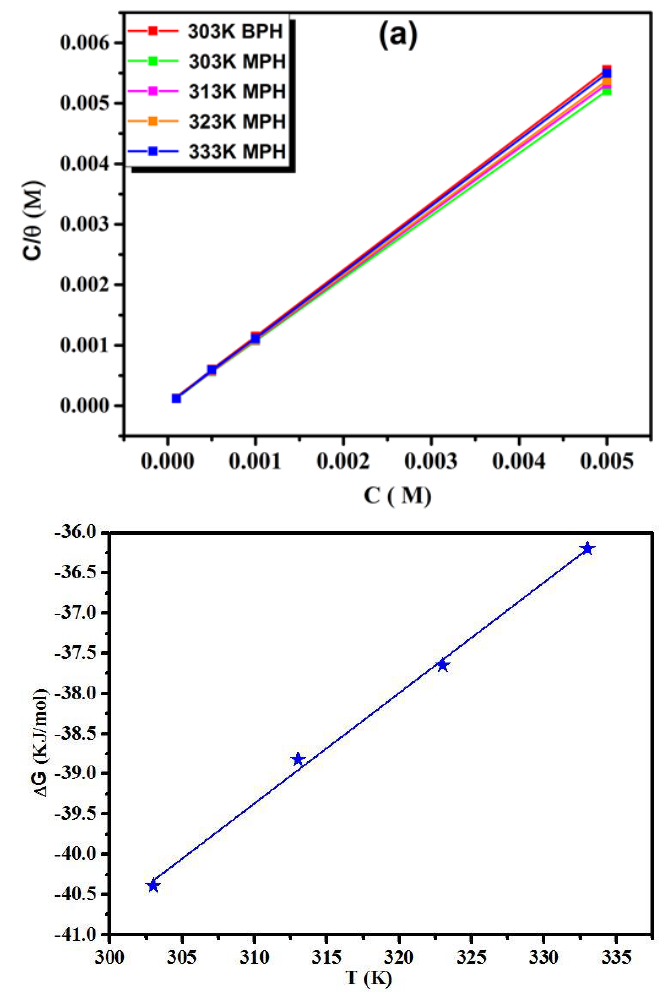
Figure 7. Langmuir adsorption isotherm plots ( a ) and regularity of the standard Gibbs free energy 𝛥𝐺 𝑎𝑑𝑠𝑂 value of MPH vs. temperature ( b ) on MS in 1.0 M HCl at different temperatures.